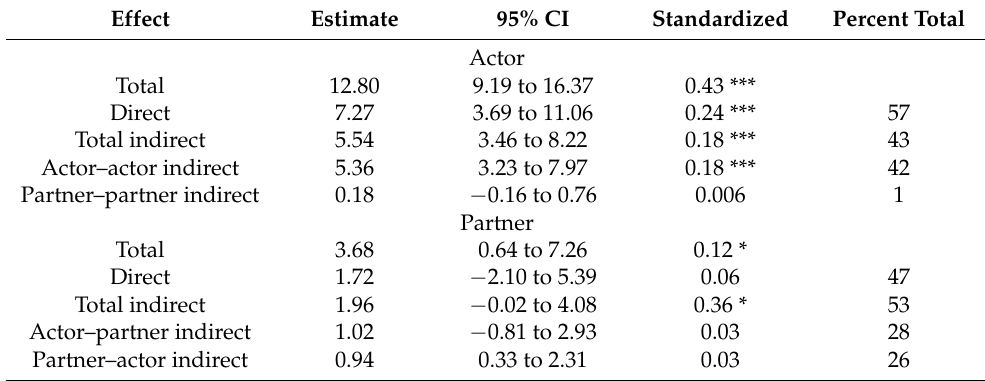
Table 8. Effects of common DC